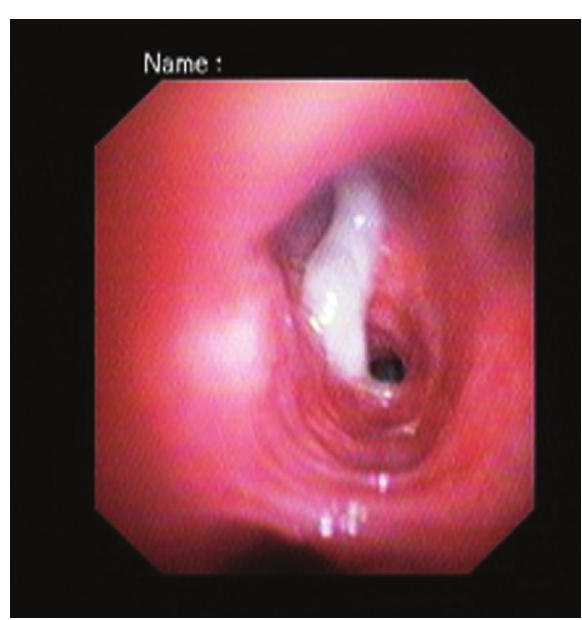
Sticky, whitish secretions in the bronchial tree.